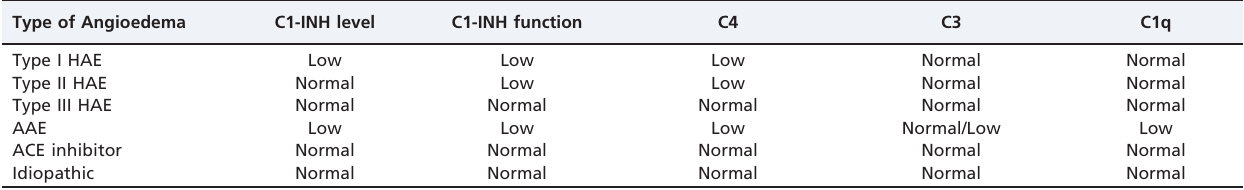
Table 2 - Laboratory diagnosis of angioedema.